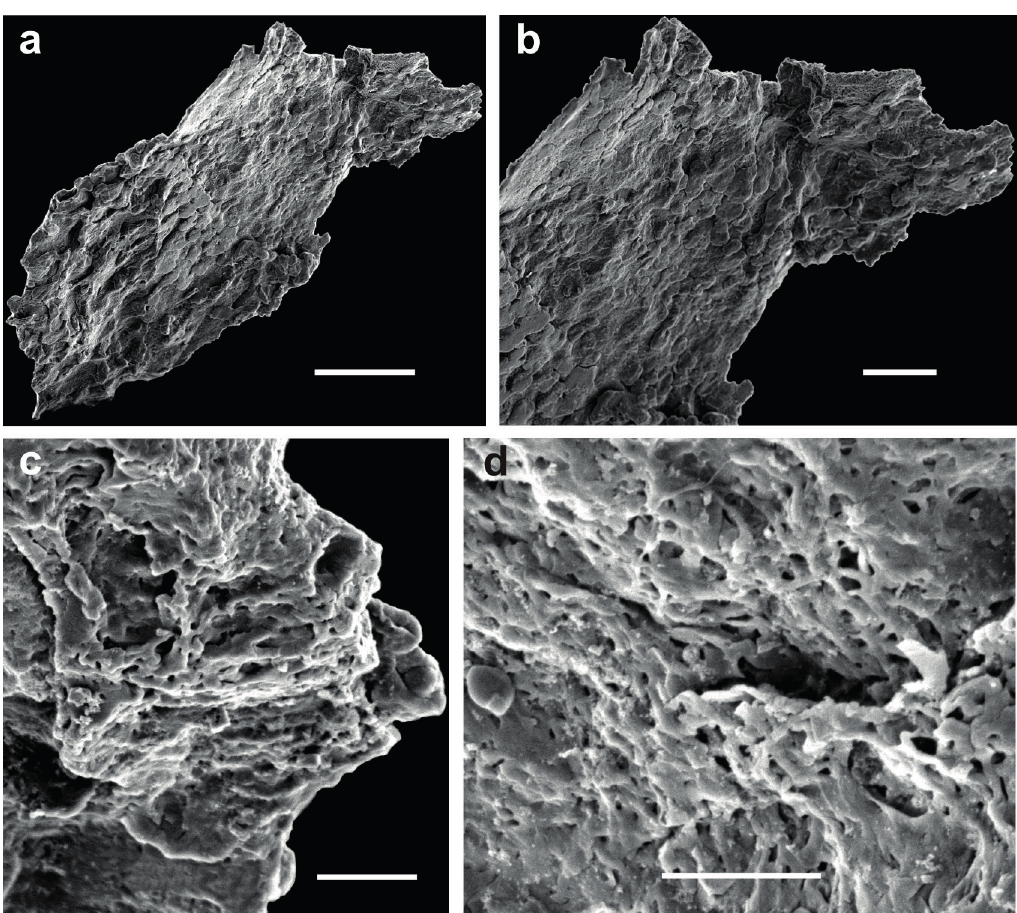
Figure 4 - Lagenoisporites magnus . Detail of the megaspore fracture observed with SEM. a-d. Specimen CICYttP-M 136. a: Megaspores compressed laterally with a fracture in the gula. Scale bar: 50 μm. b: Detail of the megaspore fracture. Scale bar: 20 μm. c: Detail of the gula exospore. d: Detail of the exospore which consists of fused rodlets that form a three-dimensional network with heterogeneous spaces of diverse diameters and are arranged at different levels with dissimilar orientations. Scale bar: 5